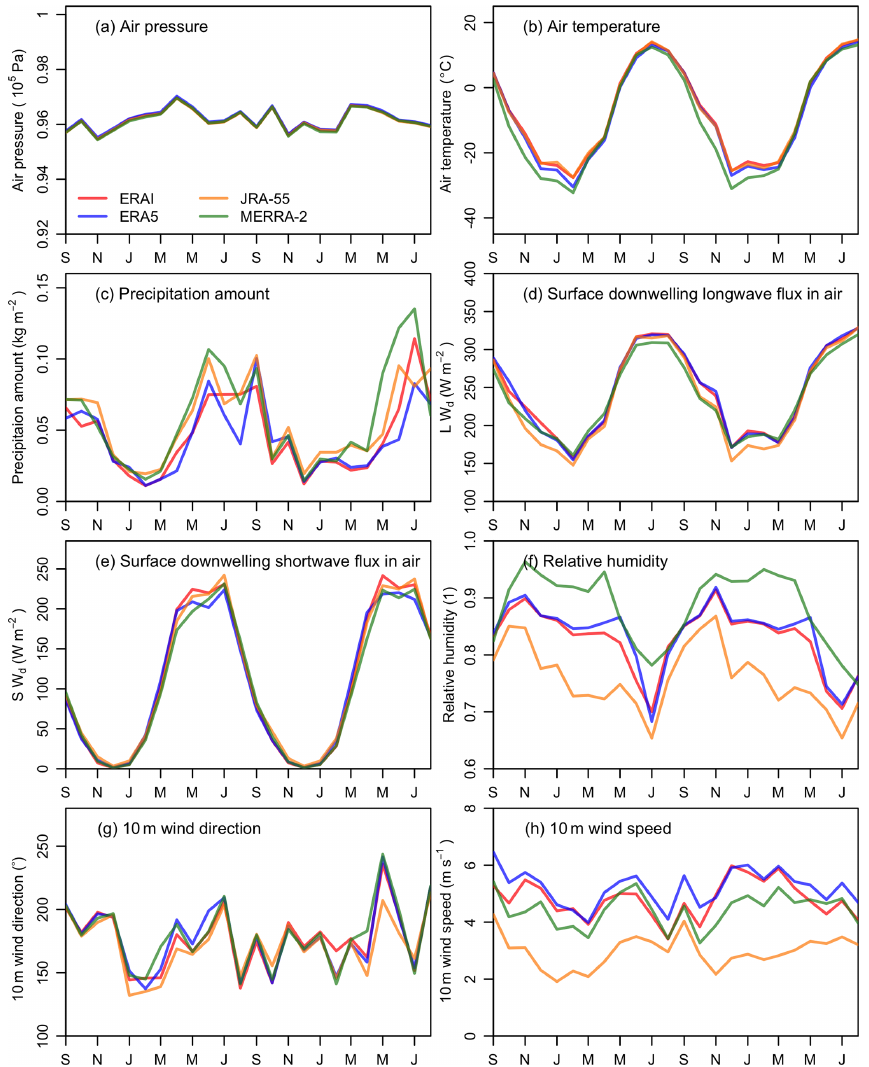
Figure 3. Intercomparisons of monthly variables derived from GlobSim which are used in GEOtop during the period September 2015– August 2017. SW d and LW d is the surface downwelling shortwave flux in air and downwelling longwave flux in air,